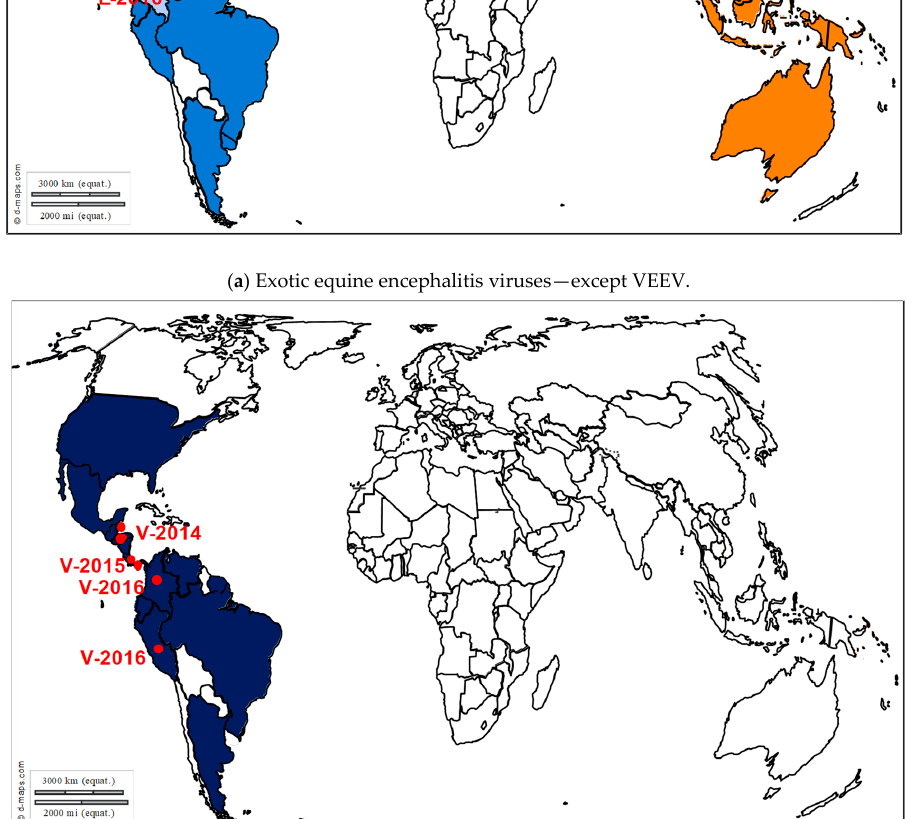
Figure 8. Distribution of exotic equine encephalitis outbreaks: Japanese encephalitis, western and eastern equine encephalitis in ( a ), venezuelan equine encephalitis in ( b ). Recent outbreaks in horses reported to the OIE WAHIS interface [15] , Promed Alerts [16] or in the scientific literature are depicted by dots (2014–2019).